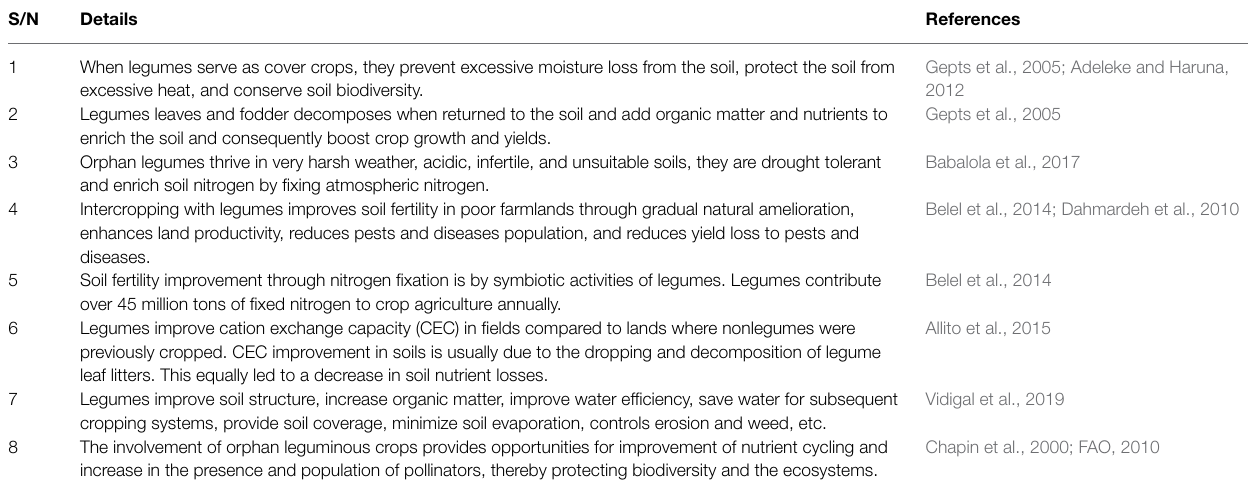
TABLE 3 | Exploitable agronomic wealth offered by underutilized